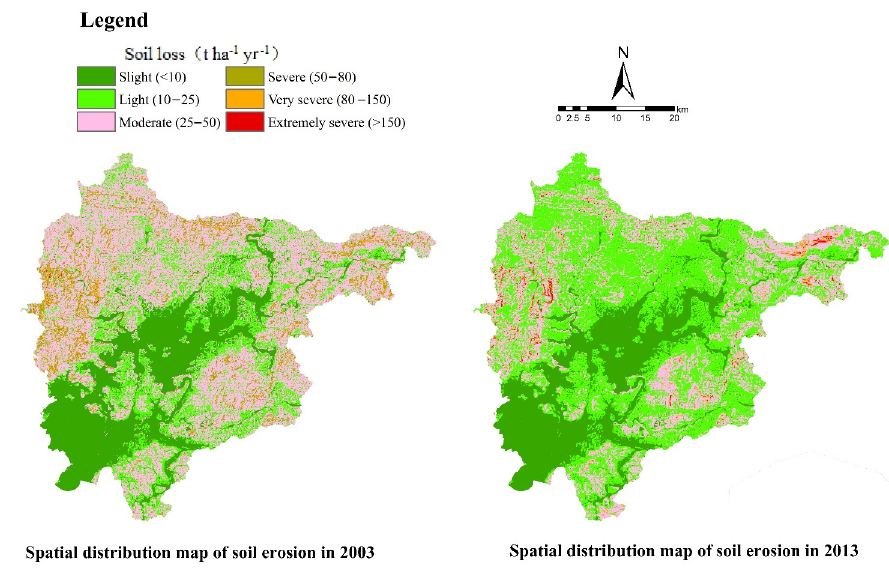
Figure 4. Annual soil loss erosion map of the study area in 2003 and 2013.